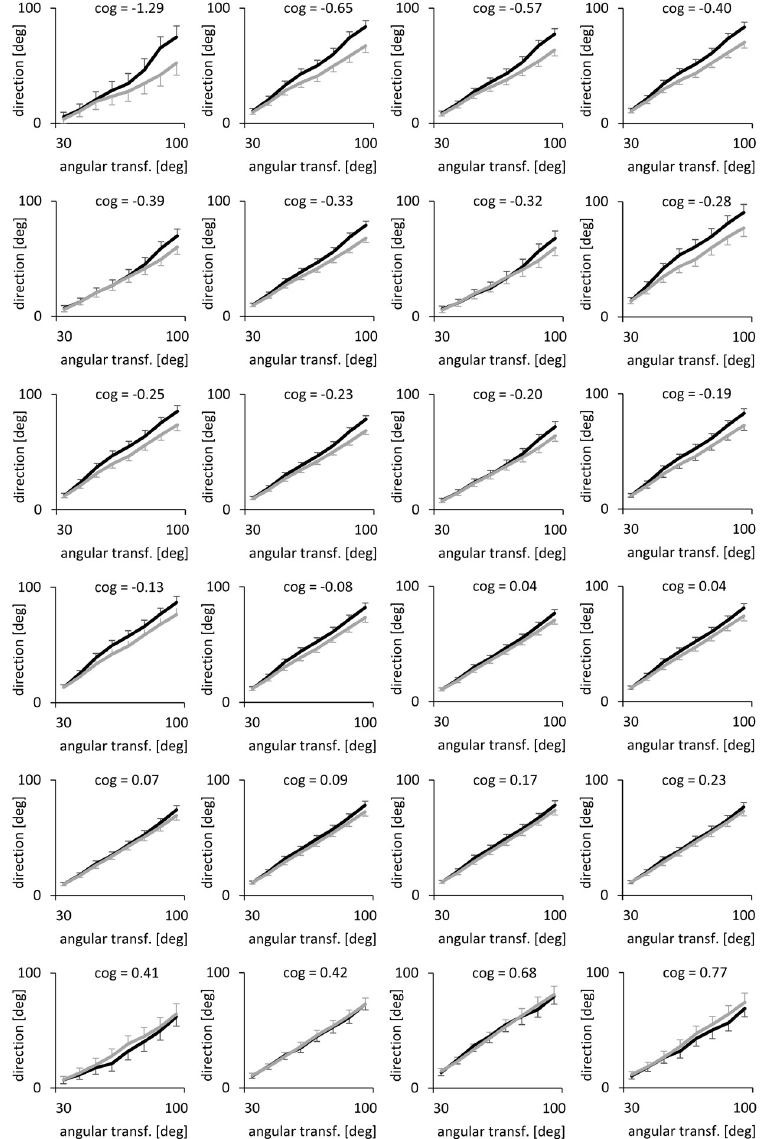
Fig 7. Predictions of the generalized linear model with mean cognitive performance change as a covariate. Predictions of the generalized linear model regarding the performance in the first and second adaptation task (black lines) compared to the third and fourth adaptation task (grey lines) with mean cognitive performance change as a covariate. Each graph shows the values of one participant. Bars represent standard errors of predictions. The size of an angular transformation corresponds to the expected value for complete adaptation. 0˚ represents the unadapted expectation. "cog" denotes the z-transformed mean cognitive performance change of one participant. As a reference, the mean cognitive performance change of the passive control group might be considered, which was 0.19 (SD: 0.20). block � order � workspace � episode (F(10,210) = 1.98, p = 0.040, ŋ 2 = 0.09). Notably, pre-test p performance was not a significant covariate for these interactions. Pre-test performance was significant covariate for block (F(5,105) = 3.44, p = 0.022, ŋ 2 = 0.12), session � block � workspace p (F(10,210) = 3.19, p = 0.001, ŋ 2 = 0.13), block � order � workspace (F(5,105) = 2.31, p = 0.049, p = 0.10), transformation � order � episode (F(14,294) = 2.23, p = 0.045, ŋ 2 = 0.10) and trans- ŋ 2 p p formation � session � workspace � episode (F(28,588) = 1.62, p = 0.033, ŋ 2 = 0.07). p